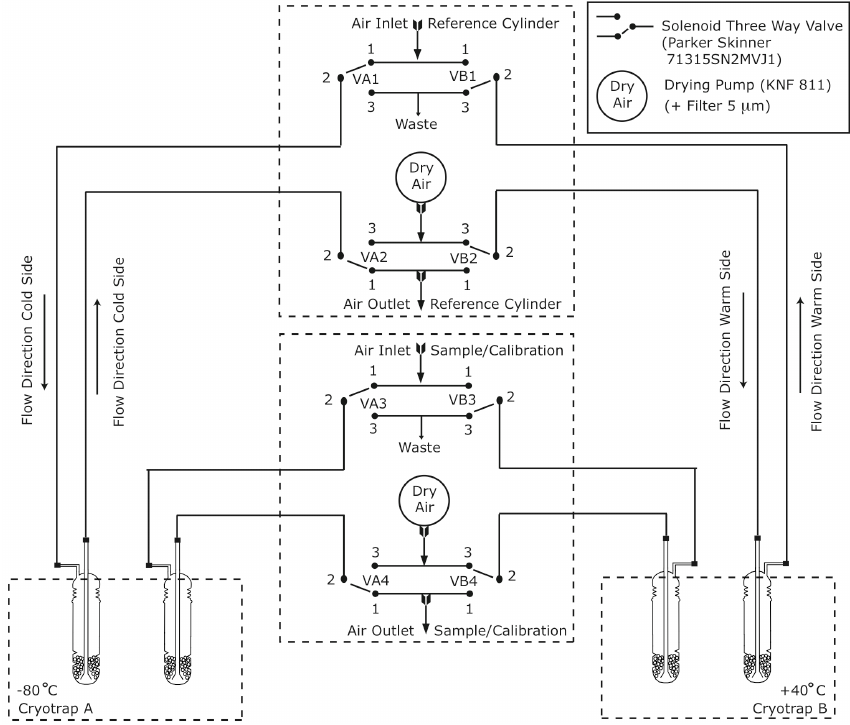
Fig. 2. Schematic of the automated air-drying setup. Cryo-trap A and B are alternately cold ( − 80 ◦ C) or warm (+40 ◦ C) in order to, respectively freeze out water from the sample air or to clear the traps of